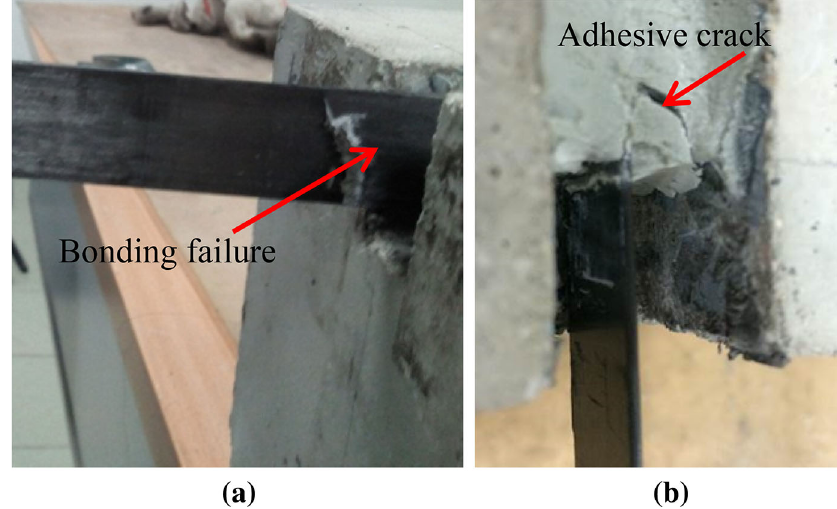
Fig. 7 Failure modes of specimen. a CFRP–adhesive bond failure, b adhesive